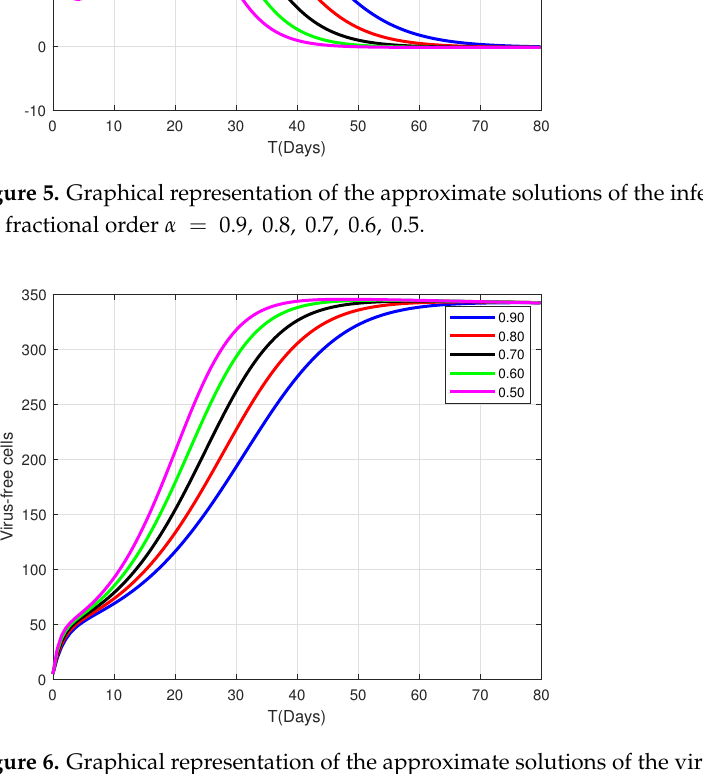
Figure 6. Graphical representation of the approximate solutions of the virus-free epithelial cells for fractional order α = 0.9, 0.8, 0.7, 0.6, 0.5.